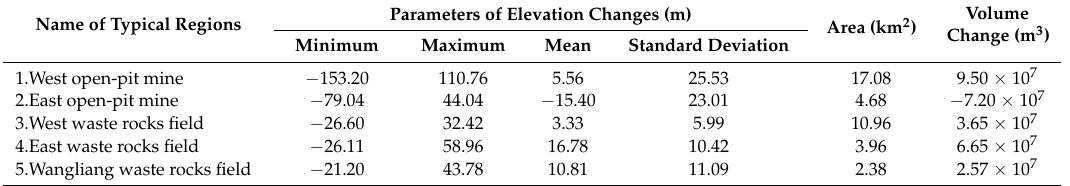
Table 5. Results of the deformation in typical regions with ZY-3 DSM in 2015 and ASTER